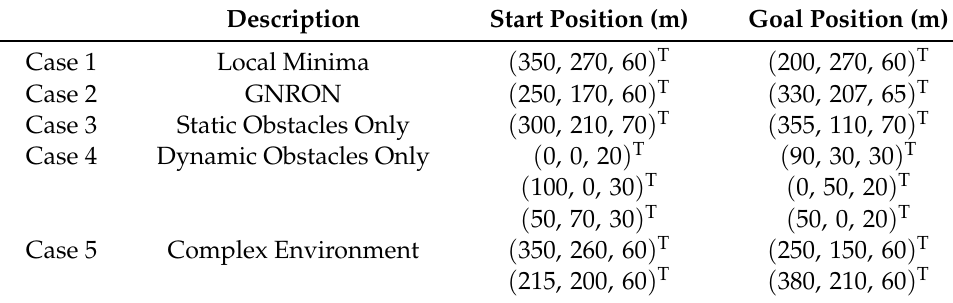
Table 3. Start and goal positions of unmanned aerial vehicles (UAVs) for each